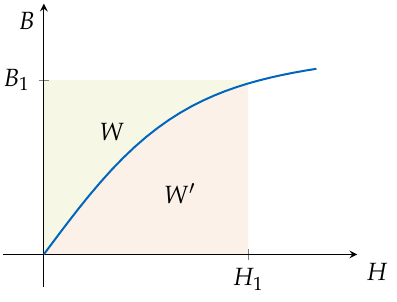
Figure 7. Magnetic energy and co-energy for a nonlinear